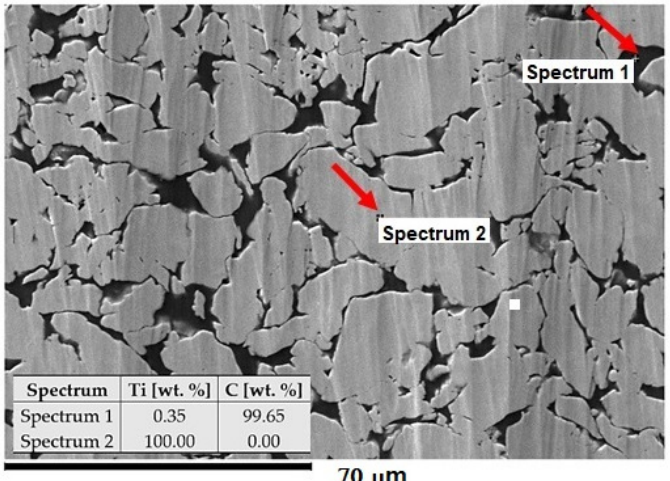
Figure 1. Structure of Ti-graphite composite with the composition of elements. The SEM image was taken at 800 × magnification.